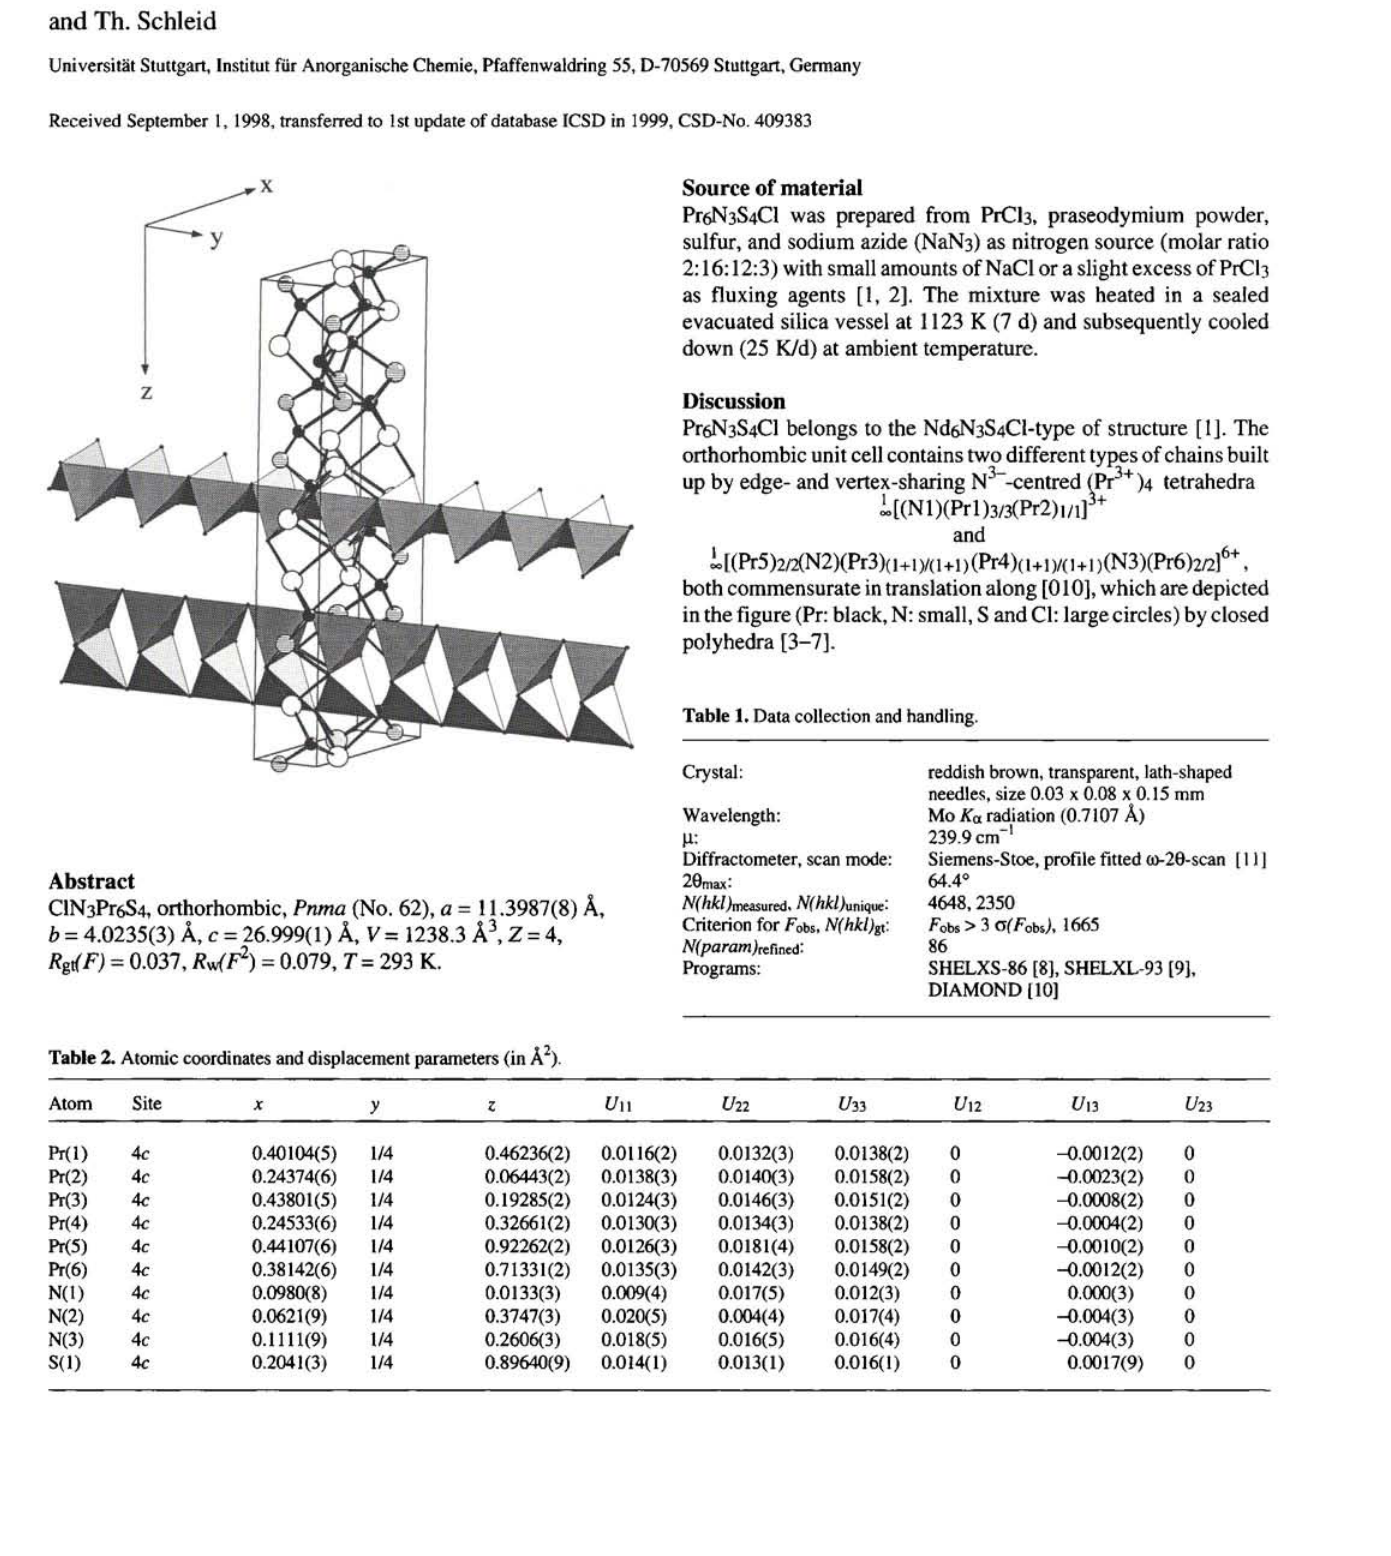
in the figure (Pr: black, N: small, S and CI: large circles) by closed polyhedra [3-7].